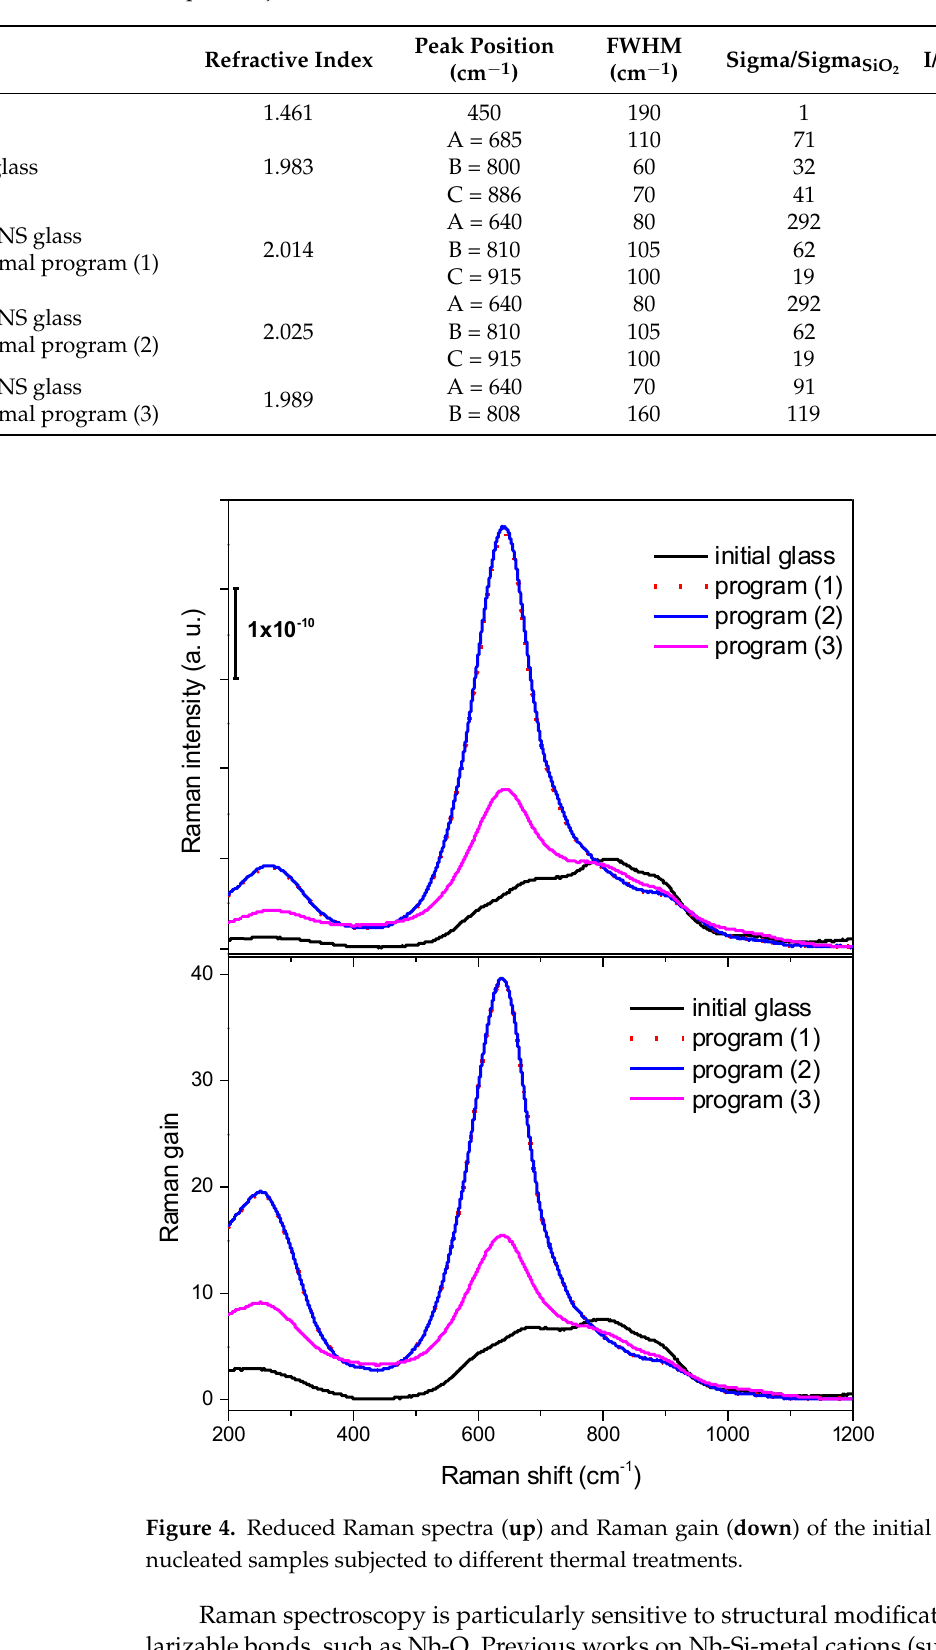
Table 1. Raman and refractive properties of a silica glass and of the initial BaNaNS glass and nucleated samples subjected to different thermal treatments.